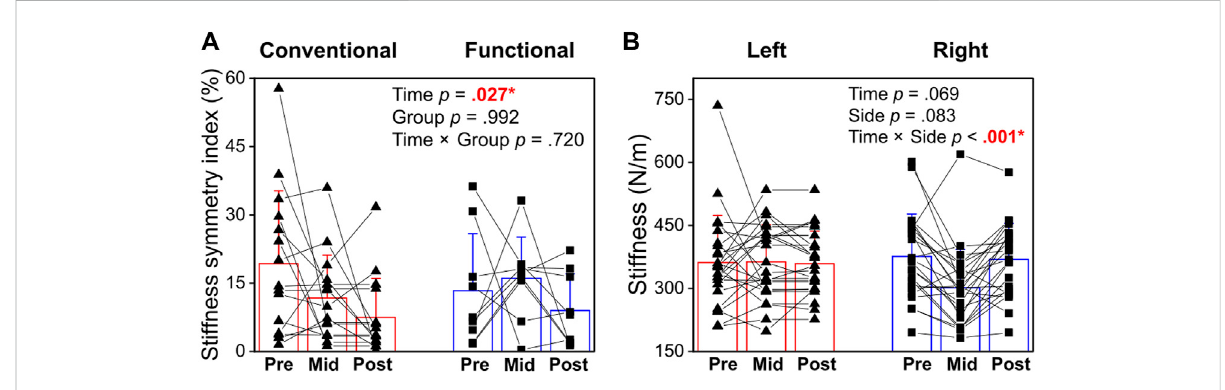
FIGURE 5 (A) Symmetry indexofpassivemusclestiffnessatpre-,mid-and post-intervention inConventionalandFunctional training groups. (B) Changes in back muscle stiffness over time in left and right back muscles. *Statistical signi fi cance ( p < 0 .05) is shown in red font and indicated by an asterisk.